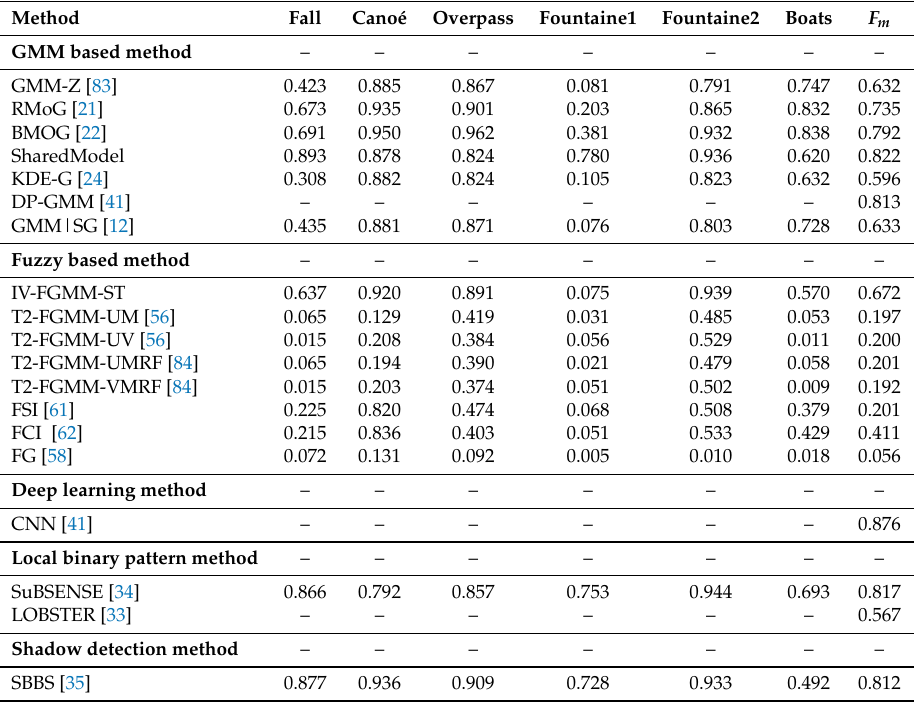
Table 9. F -measures of all